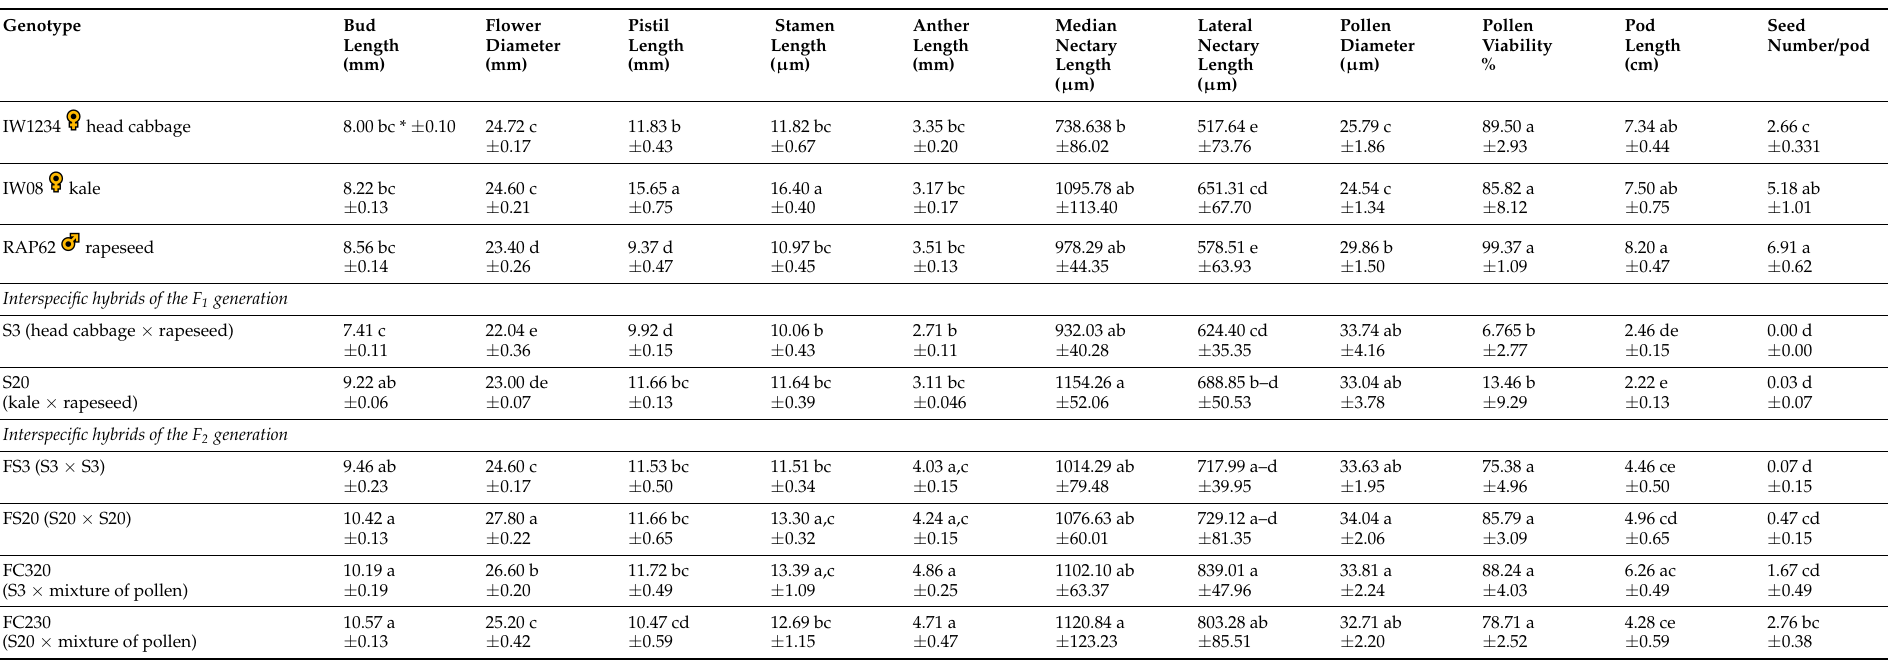
DNA Chromosome Std. dev. Content (pg) Number